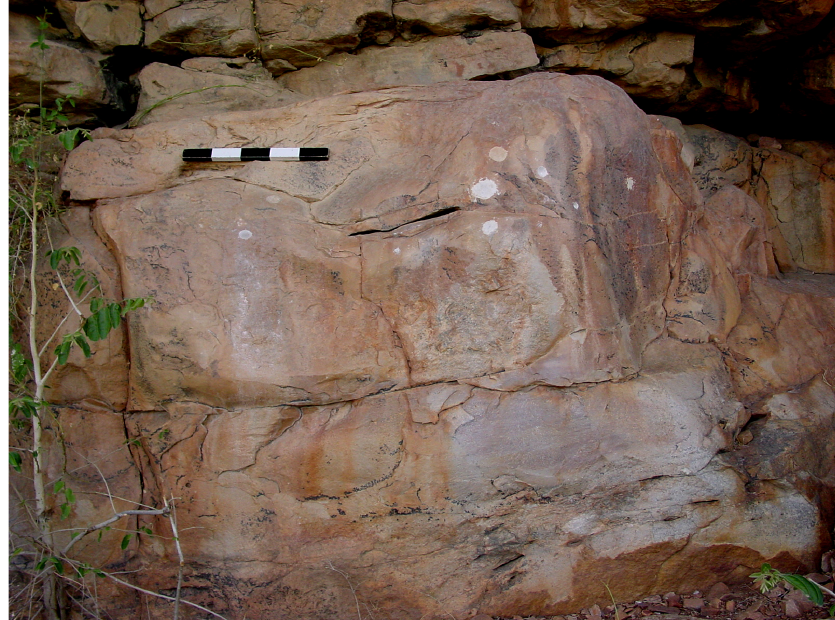
Figure 4. Experimental rock by the southern side of DC for replication of